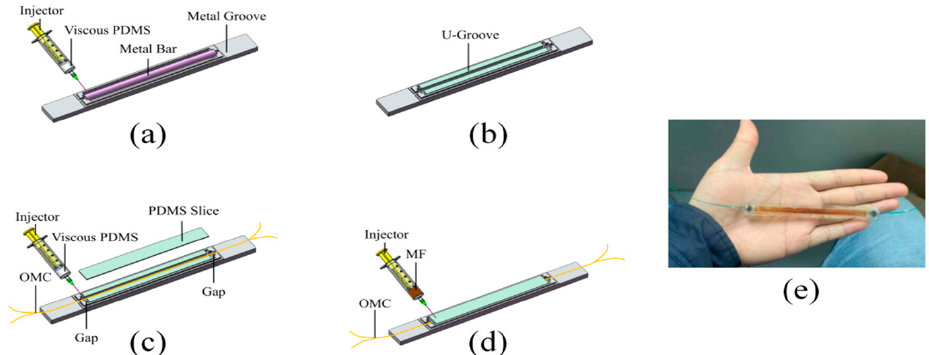
Figure 3. Sensor fabrication process. ( a ) Fabrication process of U-shaped groove. ( b ) U-shaped groove after cooling. ( c ) Place the OMC in the U-shaped groove. ( d ) Injection of magnetic fluid. ( e ) Picture of sensor appearance.